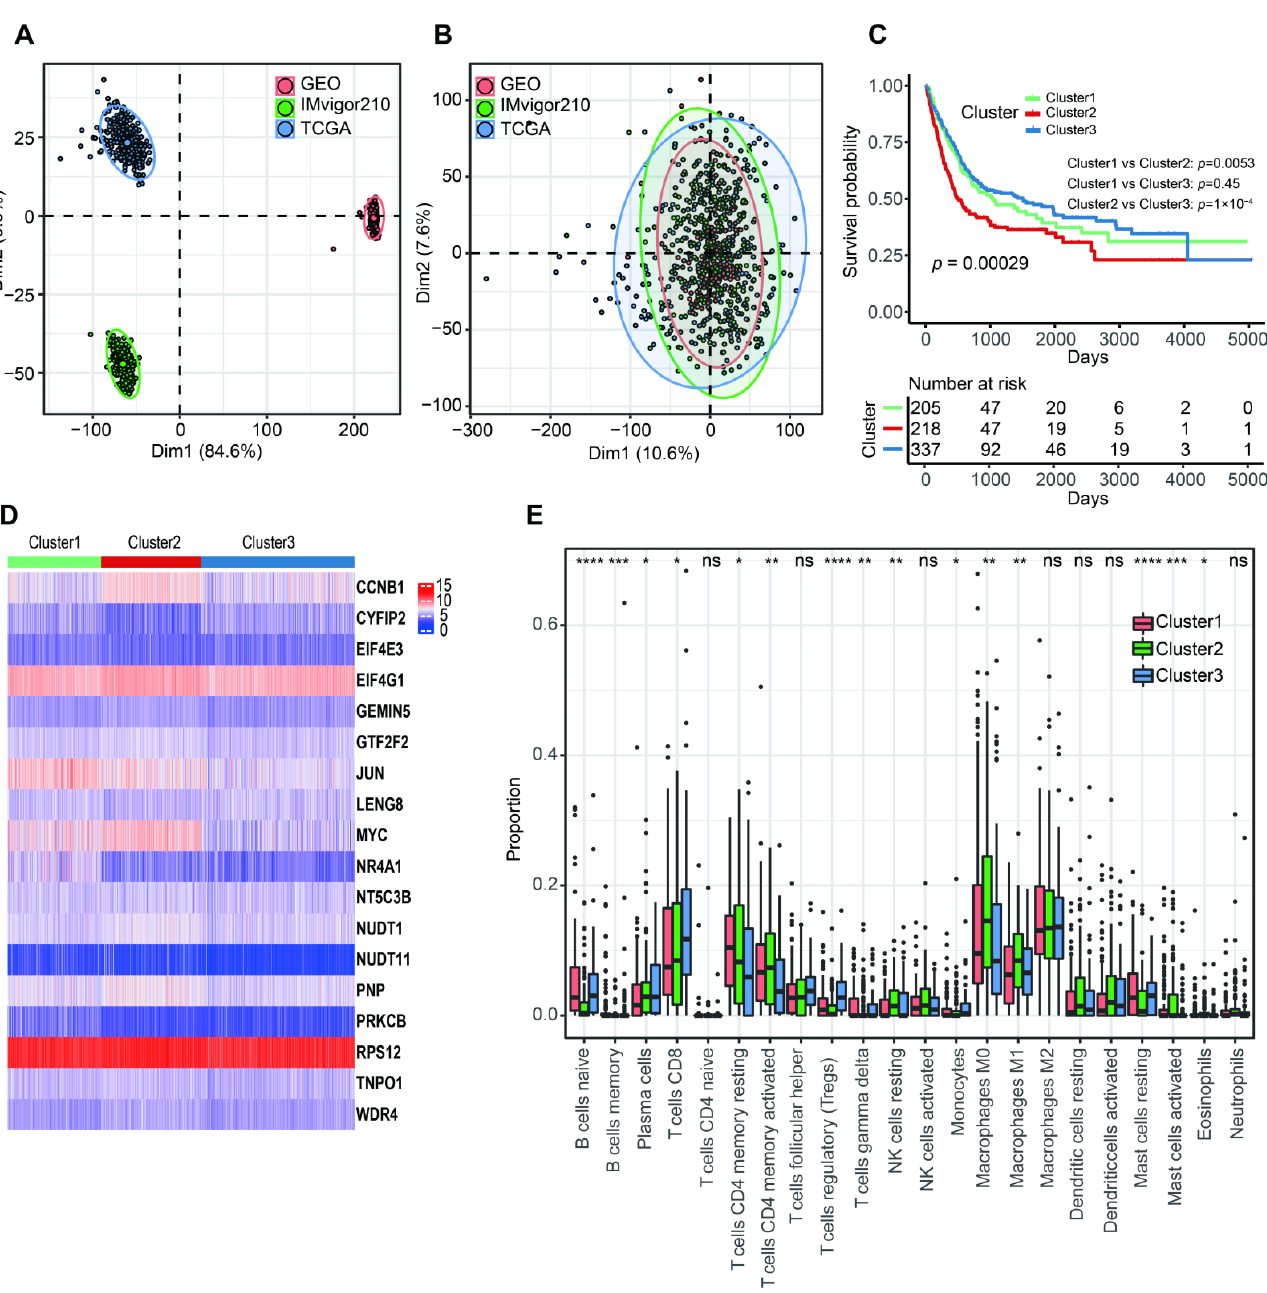
Figure 2. The characteristics of three m7G-related clusters. ( A ) Principal component analysis for the common gene profiles before combination of TCGA-BLCA, GSE13507 and IMvigor210 cohorts. ( B ) Principal component analysis for the common gene profiles after combination of TCGA-BLCA, GSE13507 and IMvigor210 cohorts. ( C ) The Kaplan – Meier survival analysis of OS among three m7G-related clusters. ( D ) The heatmap for distribution of 18 m7G-related genes among three m7G-related clusters. ( E ) The abundance of 22 tumor-infiltrating immune cells in three m7G-related clusters. Data in ( E ) were analyzed by Kruskal – Wallis test; ns, no significance; * p < 0.05, ** p < 0.01, *** p < 0.001 and **** p < 0.0001.